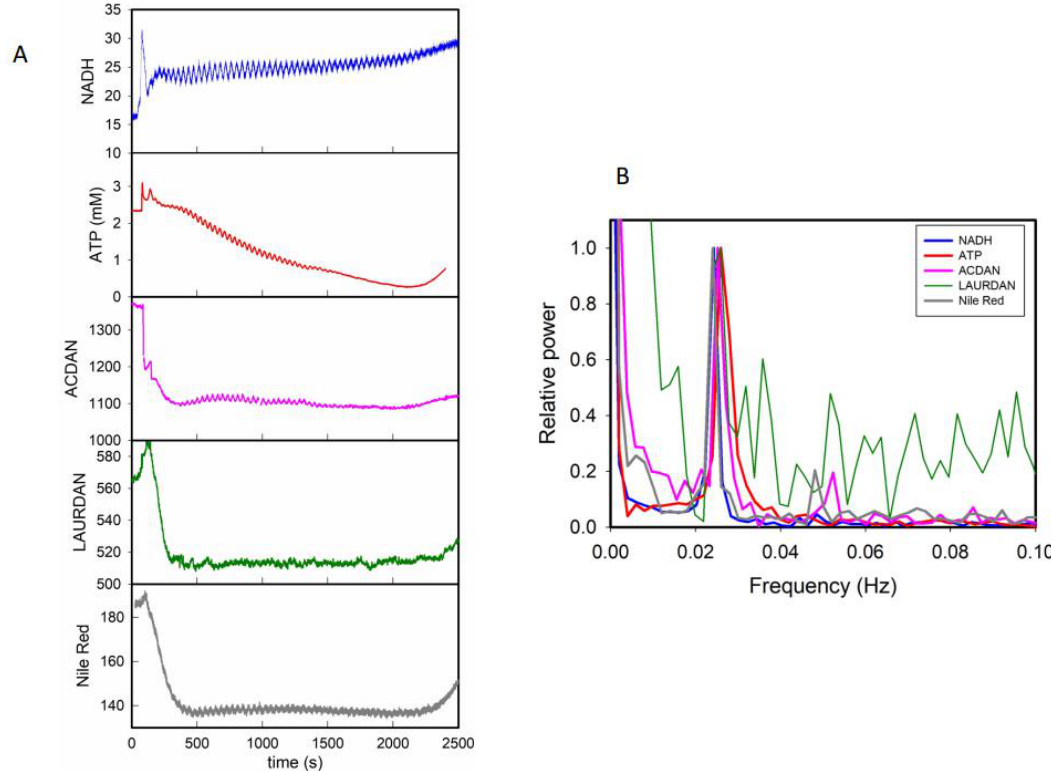
Figure 1. Oscillations in NADH, intracellular ATP, and the fluorescence of ACDAN, LAURDAN, and Nile red were synchronized. ( A ) Oscillations in NADH fluorescence, intracellular ATP concentration, ACDAN fluorescence, LAURDAN fluorescence, and Nile red fluorescence in a cell suspension with oscillating glycolysis. The cell suspension was 10% ( w / v ) S. cerevisiae BY4743 in 100 mM potassium phosphate buffer, pH 6.8, and temperature of 25 °C. Oscillations in glycolysis were induced at approximately t = 100 s by adding 30 mM glucose and 5 mM KCN to the cell suspension. ( B ) Power spectra of the oscillations in ( A ). Experimental details can be found in the Materials and Methods section.